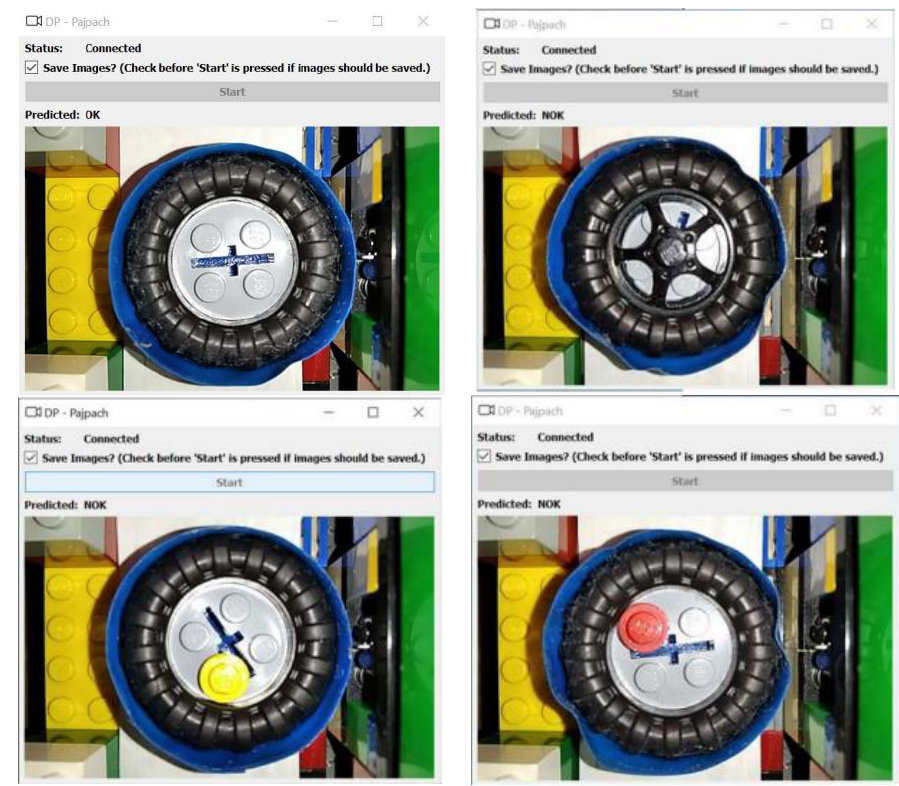
Figure 16. Results of testing CNN for second task — one-class classification.